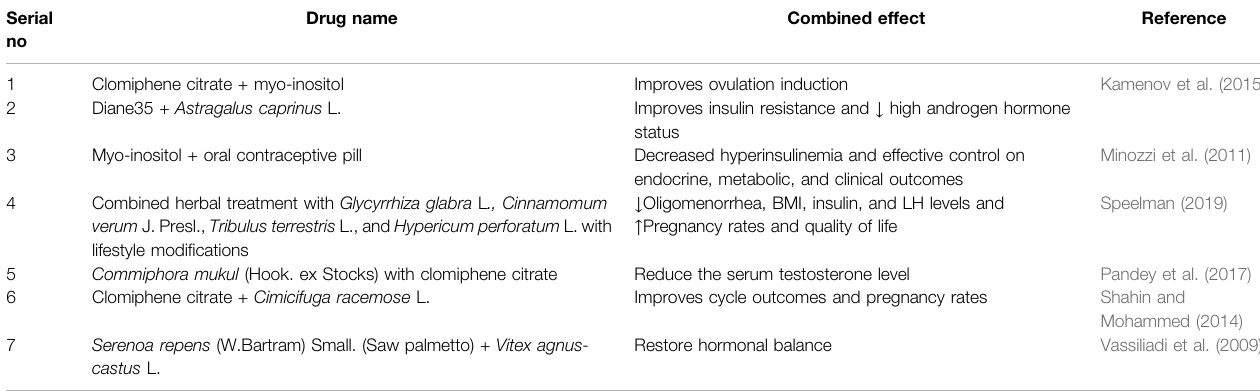
TABLE 1 | Combined therapies for the management of